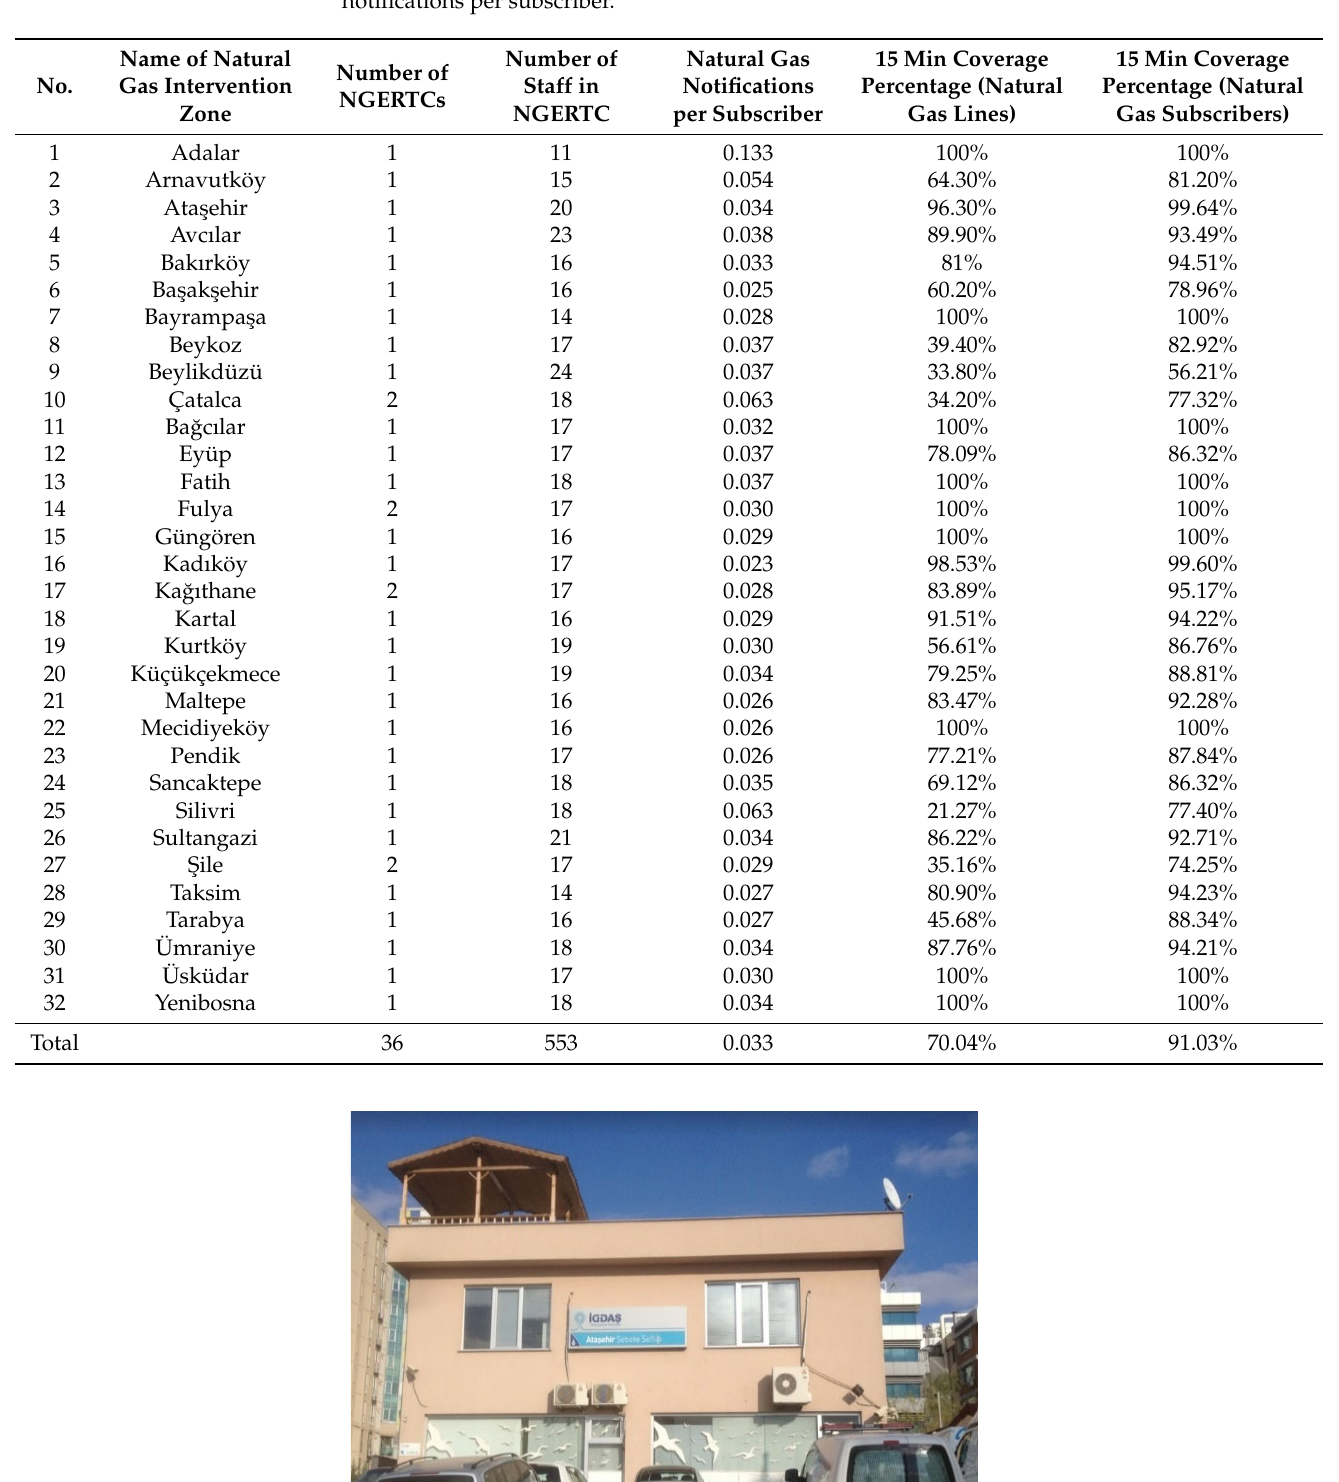
Table 1. Coverage percentage, number of NGERTCs, staff by, intervention zones and natural gas notifications per subscriber.